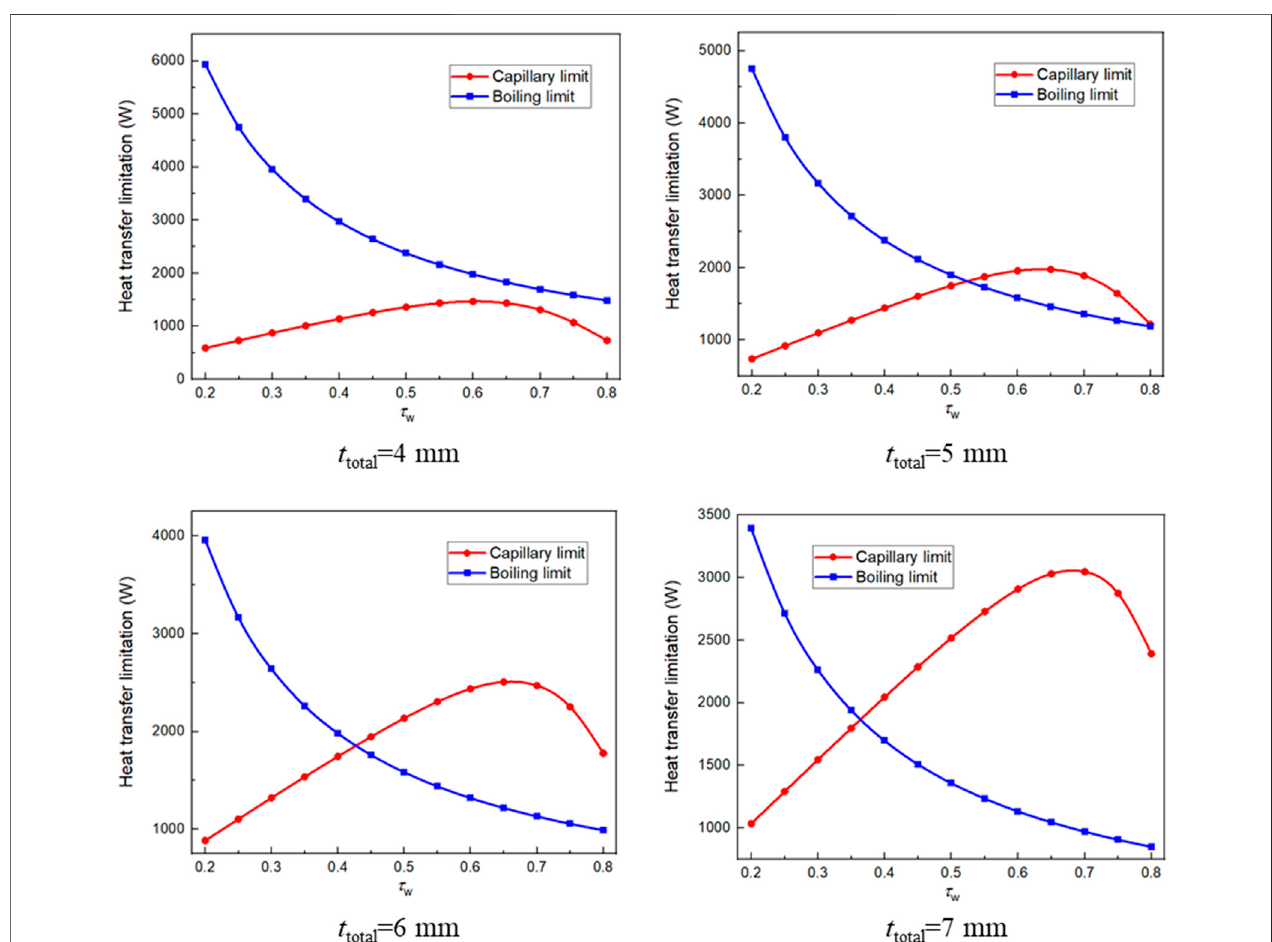
FIGURE 13 | In fl uence of τ w on FHP heat transfer limitation.